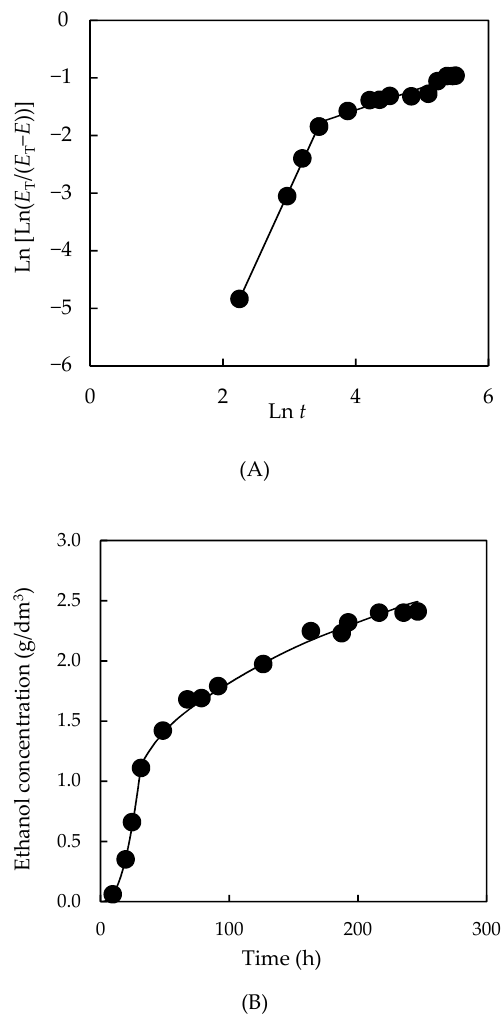
Figure 10. Ethanol production over fermentation with P. tannophilus . ( A ) Fit of the experimental data to Equation (8). ( B ) Comparison of the experimental concentrations (black points) with those predicted by model (line). Fermentation 2021 , 7 , x FOR PEER REVIEW